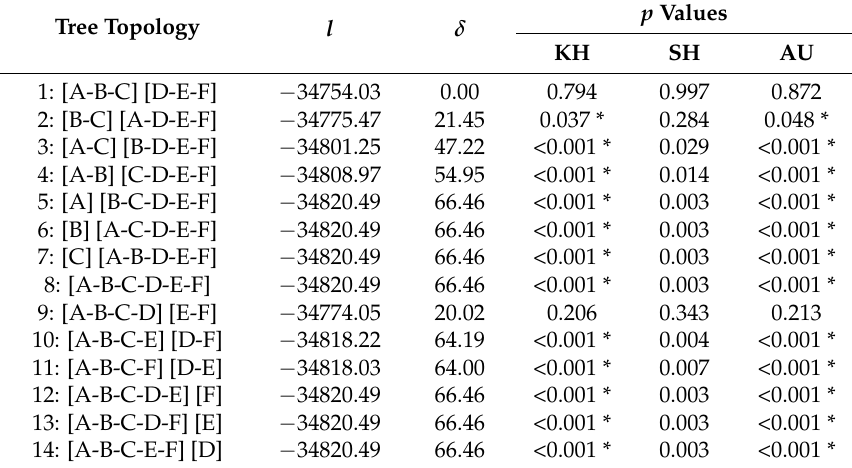
Table 2. Comparison of the statistics of the phylogenetic hypotheses. Tree